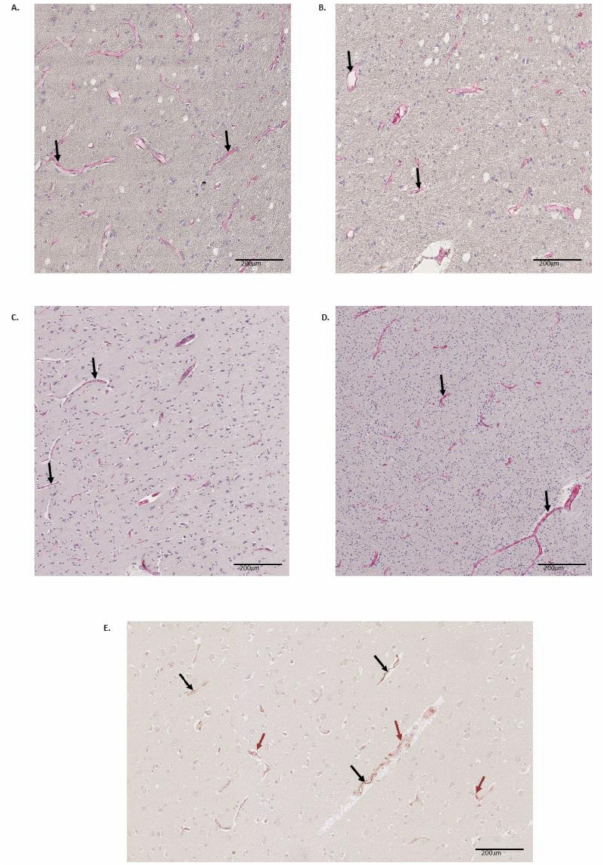
Figure 1. Expression of CD31 and vWF by cerebral microvascular endothelial cells. The cerebral microvascular endothelial cells expressed the biomarkers (black arrows) in di ff erent regions of the brain. The images are representative illustrations of the immunoreactivity of CD31 ( A , B grey and white matter of precentral gyrus × 400) and vWF ( C , D grey and white matter of the rhinal cortex × 400). Co-expression of CD31 and vWF in the hippocampus ( E grey matter of hippocampus, × 800, black arrow indicates CD31 expression and red arrow indicates vWF